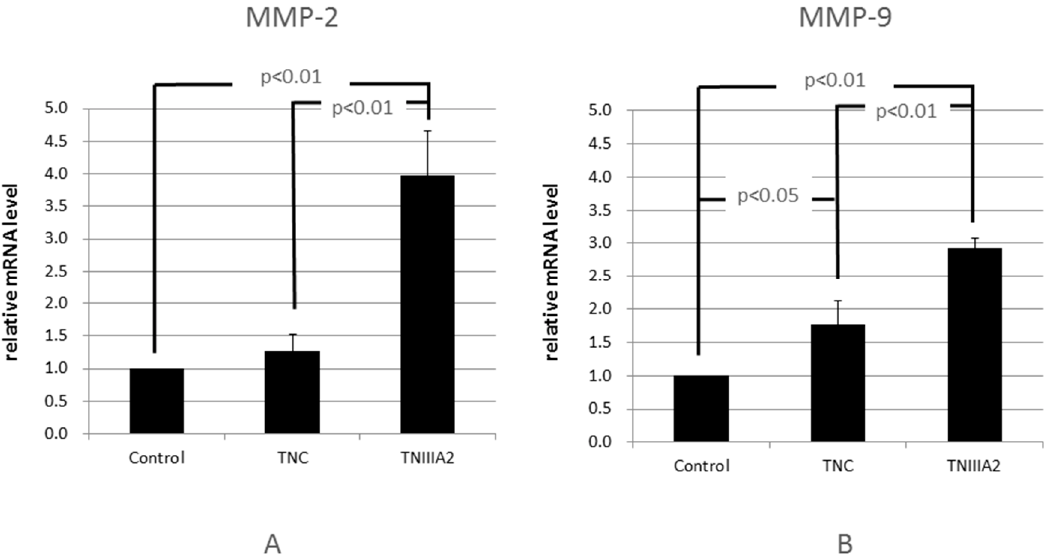
Figure 2. TNC and TNIIIA2 upregulate the mRNA level of matrix metalloproteinase (MMP)-2,9 of Colon26-M3.1. Colon26-M3.1 cells (2.5 × 10 5 cells/500 μ L/well) were seeded onto a 24-well plate in the presence or absence of TNC (10 μ g/mL) or TNIIIA2 (25 μ g/mL) in serum-free medium. After incubation for 48 h at 37 °C, the mRNA levels of MMP-2 ( A ) and MMP-9 ( B ) were quantified by real-time RT PCR. Data represent the mean of three determinations ± SD.